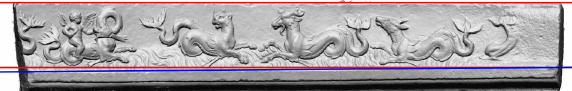
Figure 8. The main front of the frieze with the misalignment between the upper plane (red) and the cornice (blue) different positions, included in the upper cornice (always